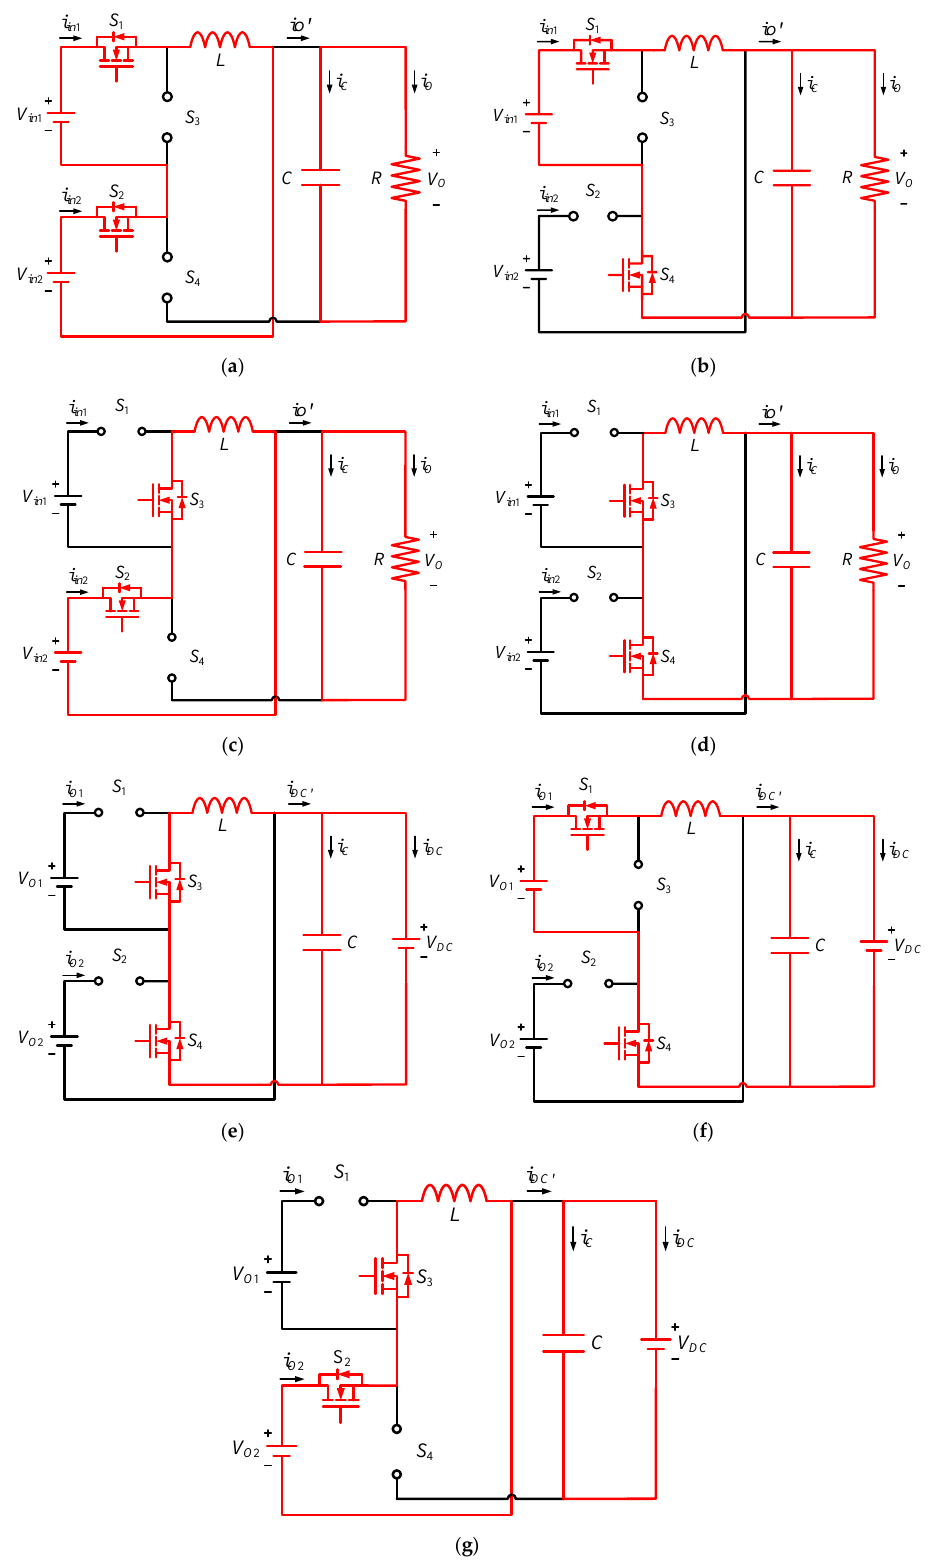
Figure 3. Equivalent circuits of di ff erent operation modes ( a ) Mode I; ( b ) Mode II; ( c ) Mode III; ( d ) Mode IV; ( e ) Mode V; ( f ) Mode VI; ( g ) Mode